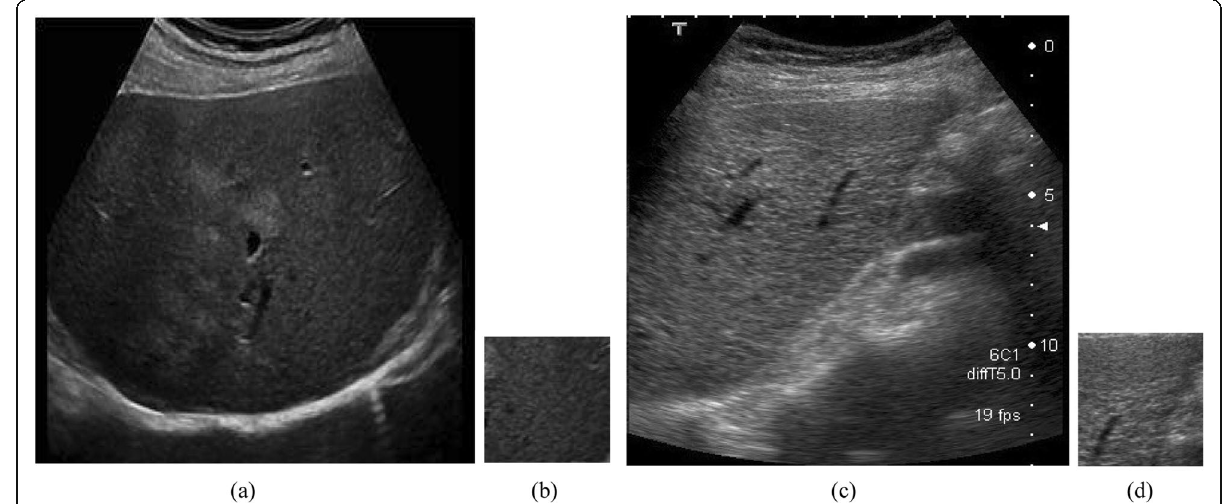
Fig.2 a US image of normal liver. b ROI from normal liver. c US image of cirrhotic liver. d ROI from cirrhotic